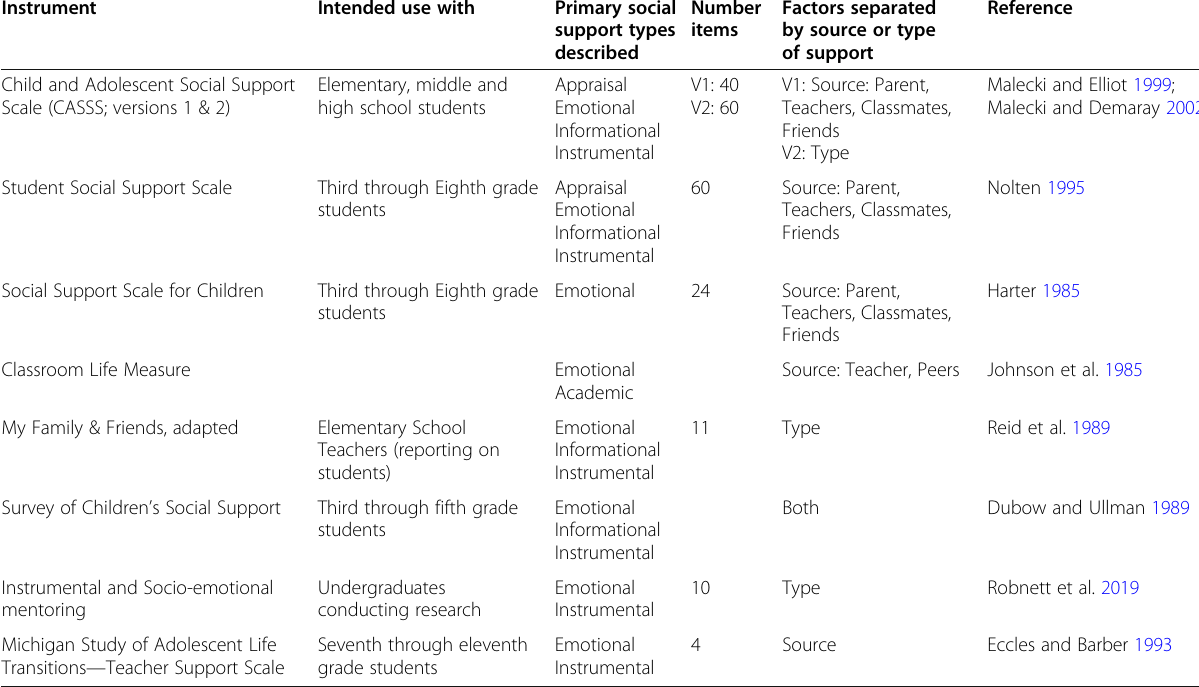
Table 1 Characteristics of existing social support instruments for use in education